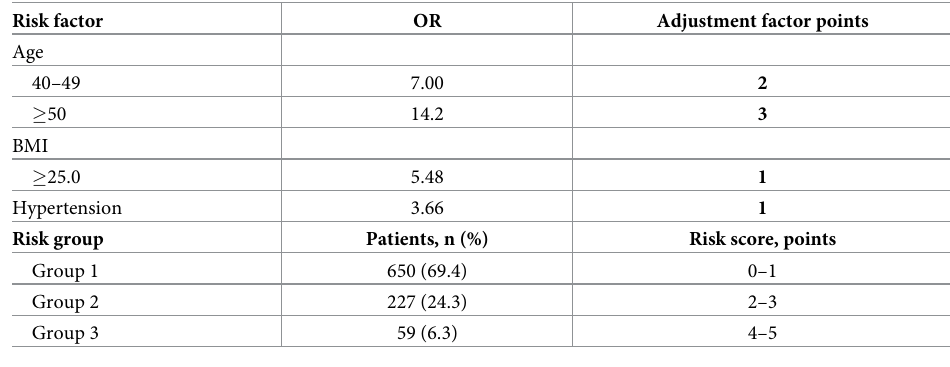
OR: Odds ratio; BMI: body mass